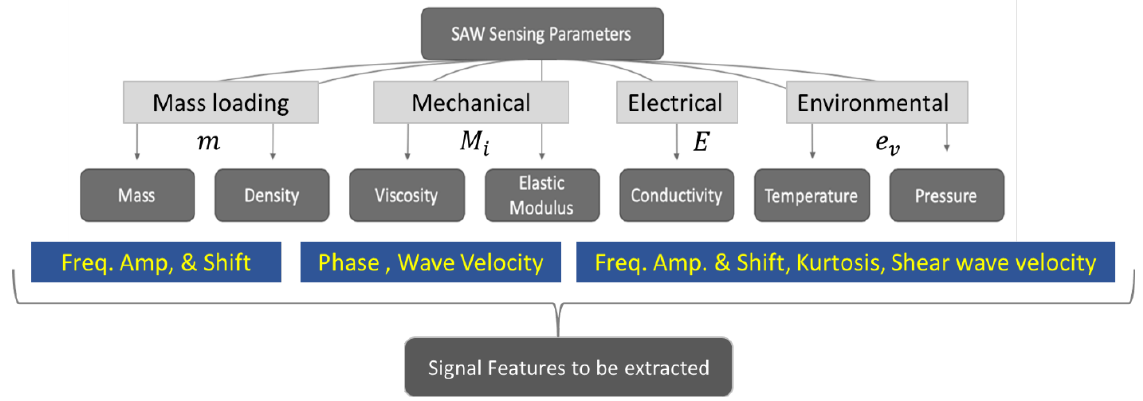
Figure 2. Classification of the SAW sensing